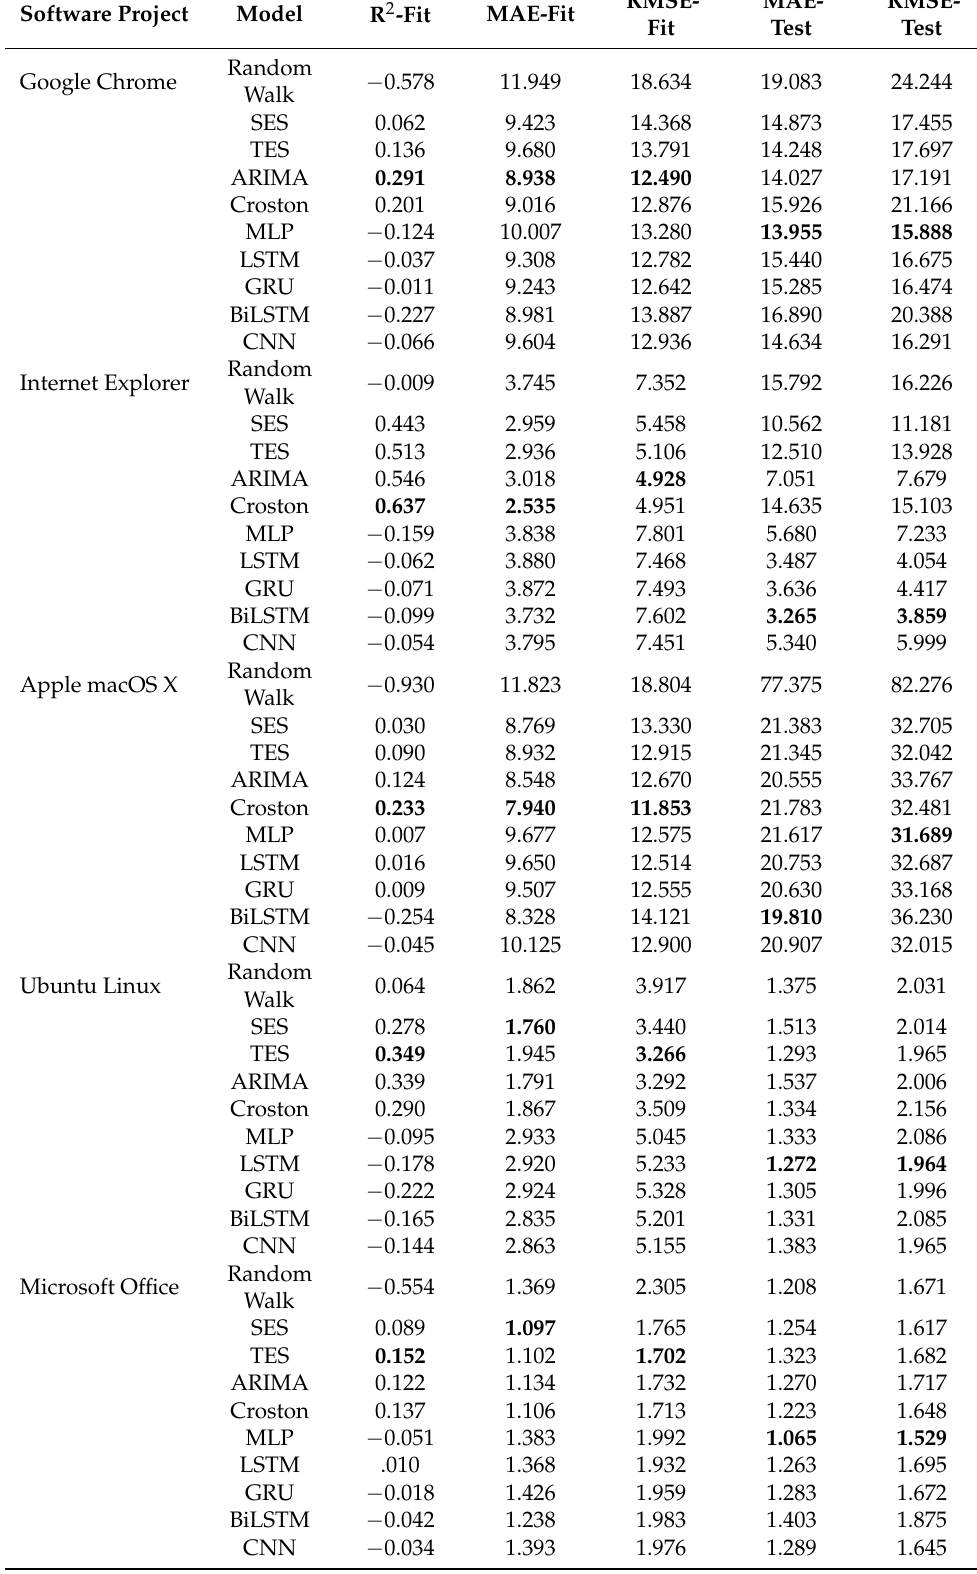
Table 9. Comparison of statistical and deep learning models’ descriptive and predictive